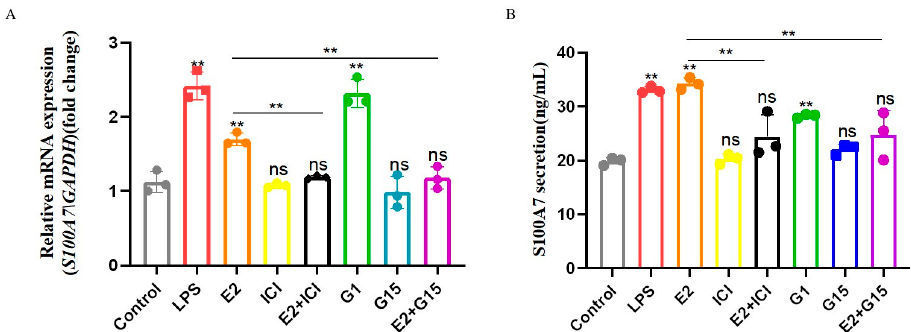
Figure 6. E2 binds to both nuclear and membrane receptors to induce expression and secretion of S100A7. ( A ) S100A7 expression of gMECs after treatment for 6 h; ( B ) S100A7 secretion of gMECs after treatment for 6 h; ICI (estrogen nuclear inhibitor, 1 μ M); G15 (estrogen membrane inhibitor, 1 μ M); G1 (estrogen membrane agonist, 0.1 μ M); ns: p > 0.05; **: p < 0.01. Different colors stand for different groups. The level of S100A7 mRNA expression for ( A ) was showed in Table S5. The concentration of S100A7 secretion in gMECs for ( B ) was showed in Table